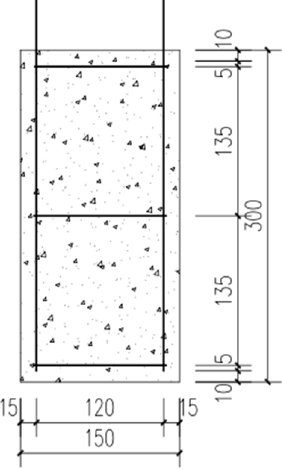
Figure 1. Specimen and reinforcement details. Table 1. Mechanical properties of the reinforcement and CFRP.